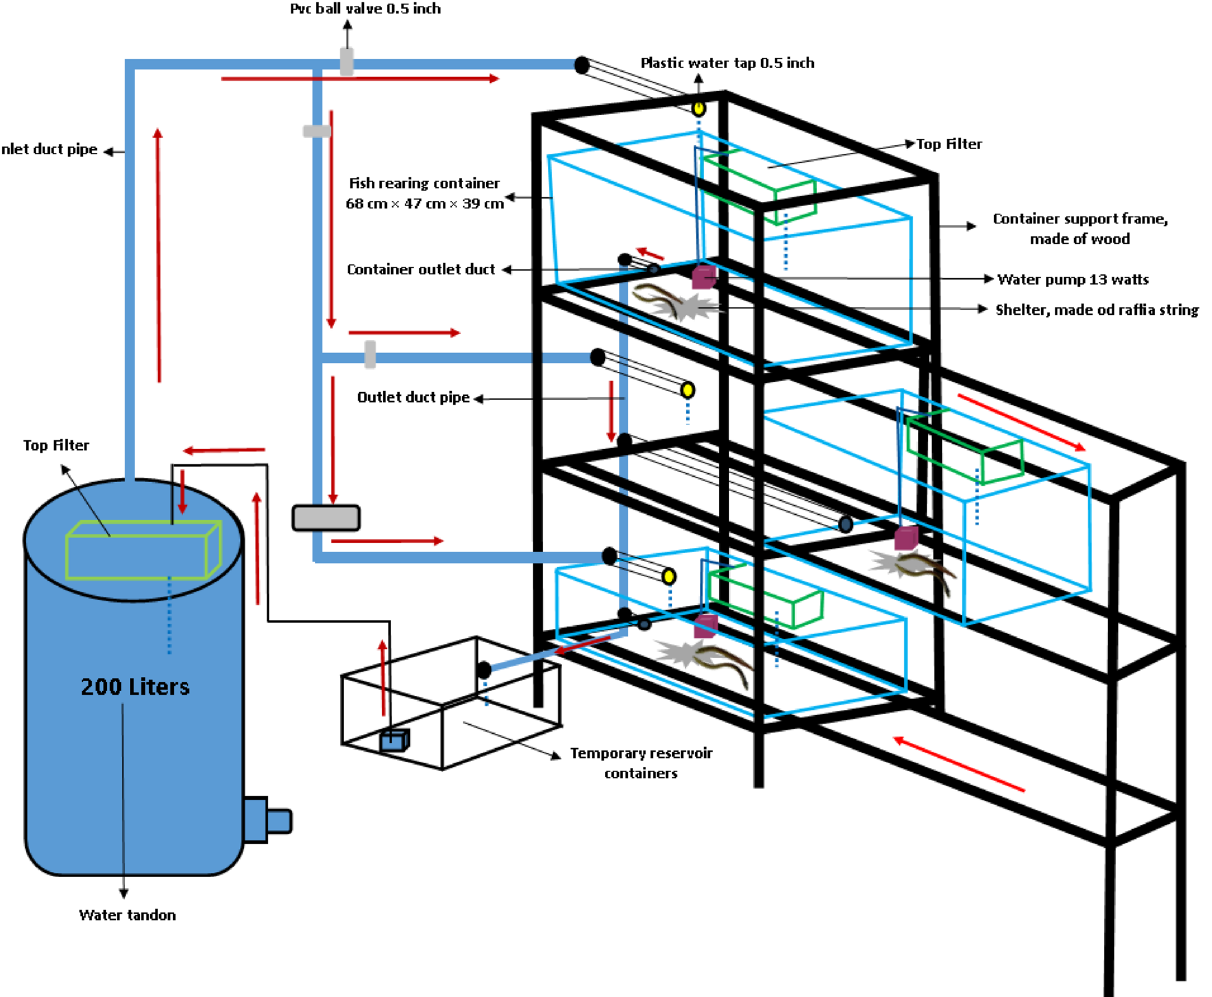
Figure 1. Experimental set up, vertical aquaculture systems (the container can be stretched horizontally to the